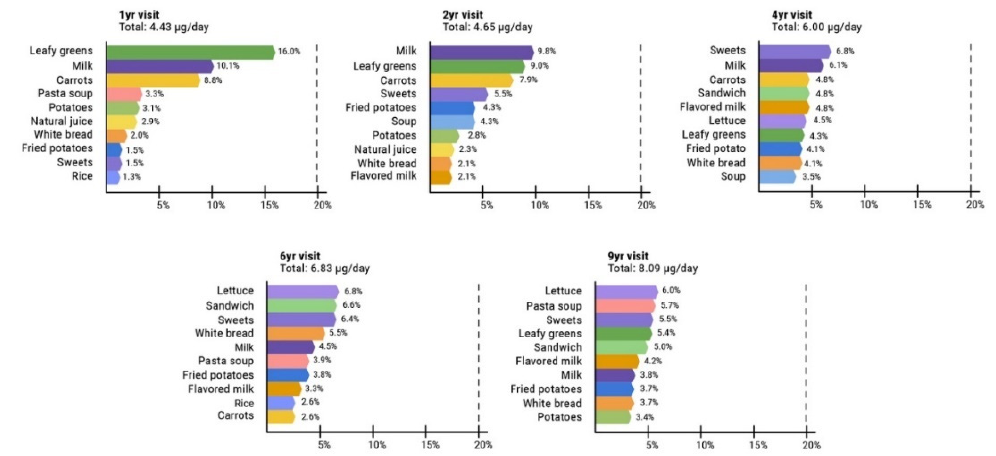
Figure 1. Primary foods contributing to estimated dietary Cd intake in 1–9-year-old children.